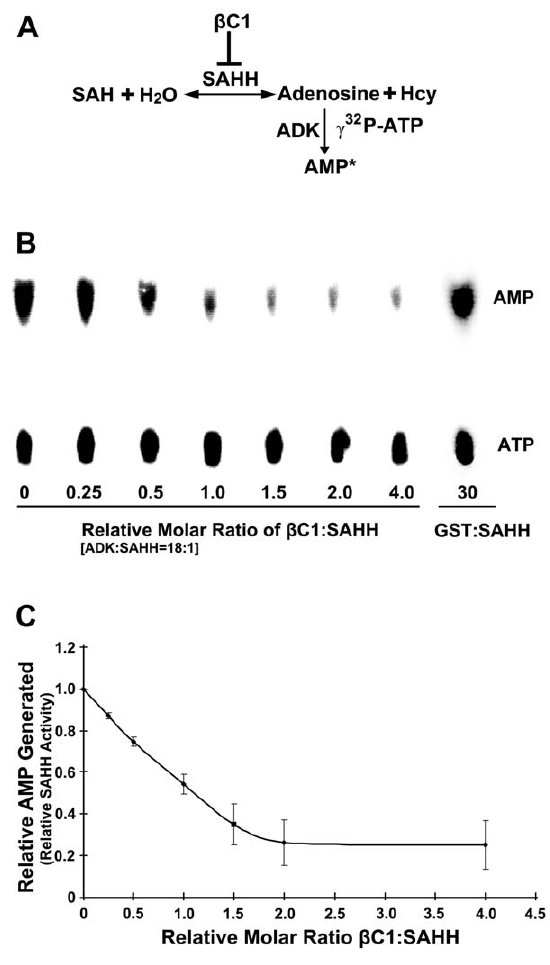
Figure7. b C1inhibits SAHHactivity invitro . (A) Diagram ofthe assay. In a reversible reaction, S-adenosyl homocysteine (SAH) is hydrolyzed by SAHH to adenosine and homocysteine (Hcy). Conversion of adenosine to labeled adenosine monophosphate (AMP*) by ADK in the presence of labeled c 32 P-ATP drives the reaction in the direction of hydrolysis and allows indirect quantitation of the SAHH reaction. SAH hydrolysis promotes flux through the methyl cycle and SAM production, and this is inhibited by b C1 protein. (B) Autoradiograph of a representative chromatogram showing AMP generated by ADK in reactions containing varying molar ratios of b C1 to SAHH. The positions of labeled AMP product and ATP substrate are indicated. ADK activity (AMP/AMP + ATP) in each reaction was calculated after phosphorimager quantitation of radioactivity in individual spots. GST:SAHH (30:1) served as a control. (C) Stoichiometry of inhibition. The graph illustrates relative ADK activity, an indirect measure of SAHH activity, with increasing b C1:SAHH molar ratio. Data were obtained from three independent experiments with two independent SAHH preparations. Values represent means + / 2 SE.